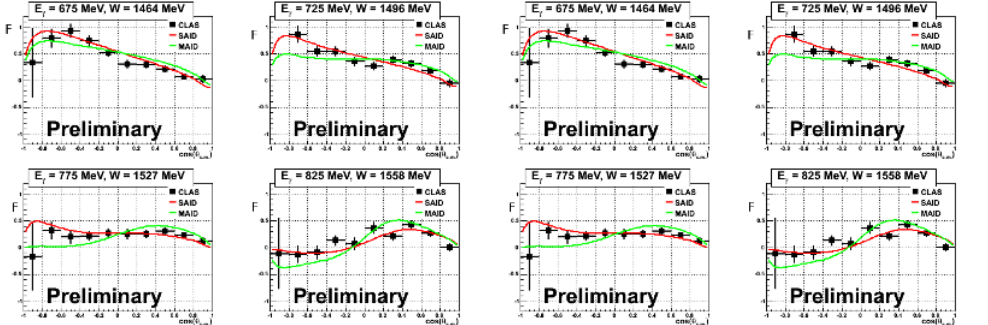
Fig. 2. Preliminary values of the F observable. Legend is the same as in Fig. 1. Data analysis by M. Dugger,